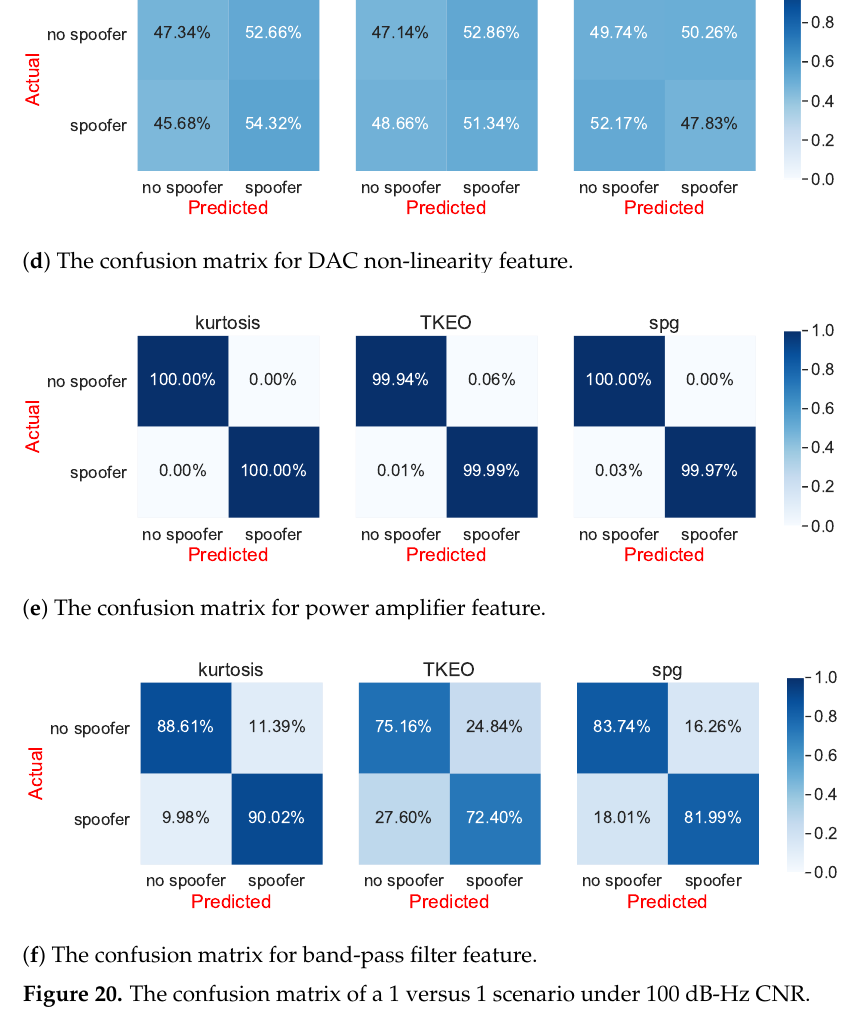
Figure 20. The confusion matrix of a 1 versus 1 scenario under 100 dB-Hz